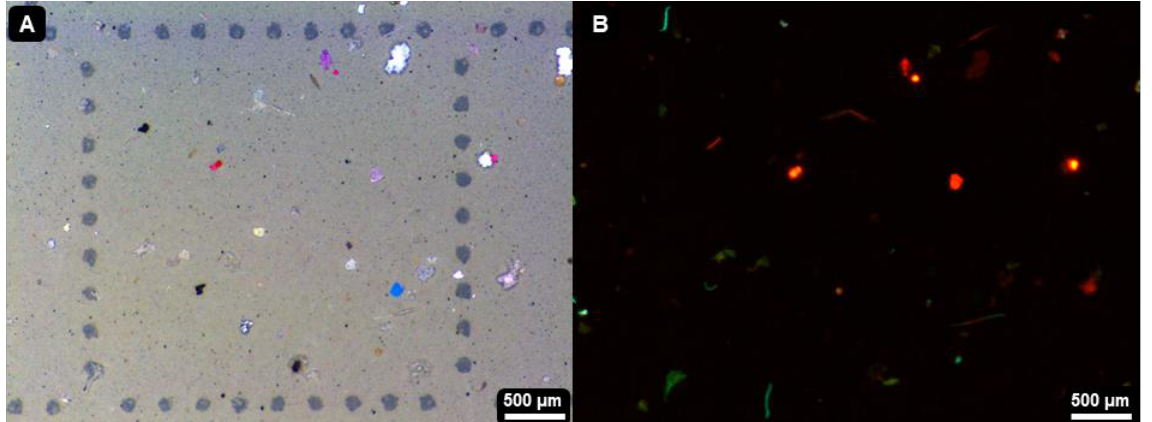
Figure 5. Microscope image of the processed and stained wastewater samples from 10.02.2022: ( A ) normal photo, ( B ) fluorescent image.